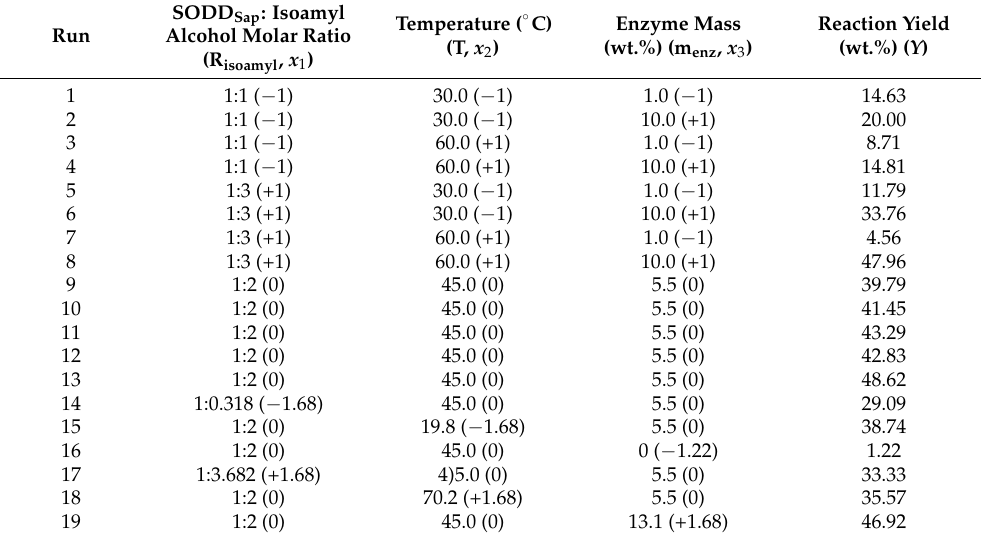
Table 2. RCCD matrix for esterification/transesterification of SODD with isoamyl alcohol catalyzed by Eversa Transform 2.0 in almost anhydrous media (incubated in shaker at 250 rpm stirring for 12 h reaction) with experimental results for fatty acid isoamyl ester yield ( Y